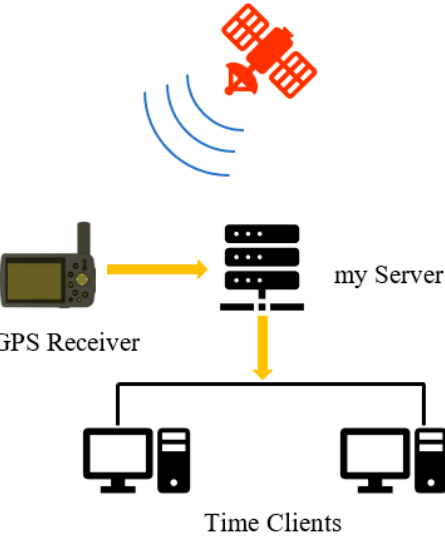
Figure 2. GPS time synchronization.